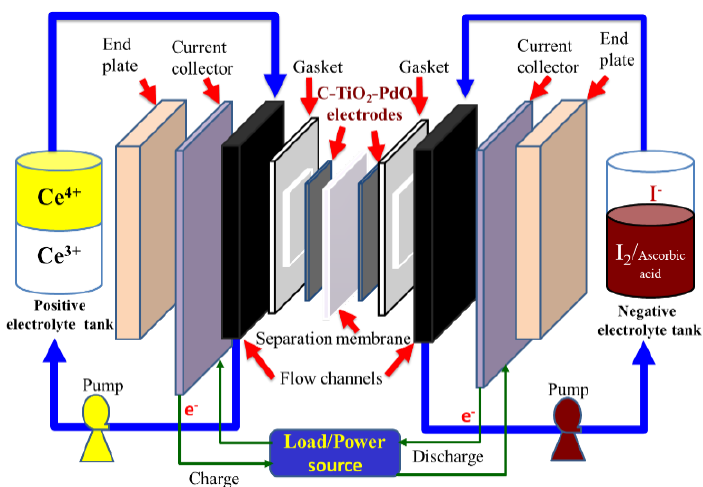
Figure 5. Schematic of the Ce/ascorbic acid/I RFB under a charge–discharge cycle.